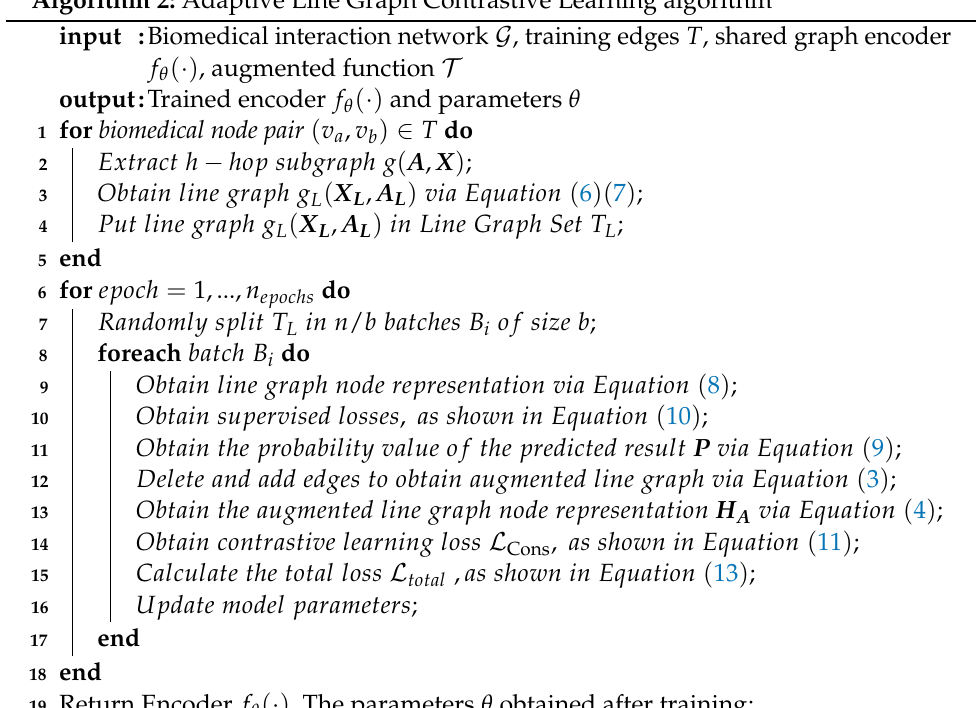
Algorithm 2: Adaptive Line Graph Contrastive Learning